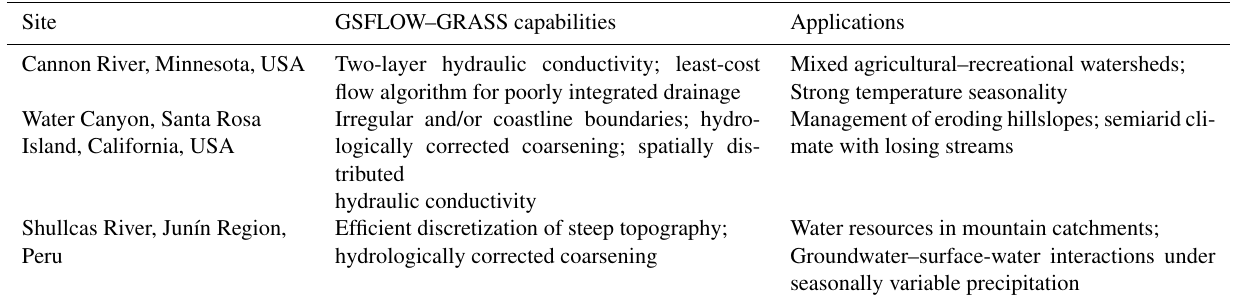
Table 3. Model implementations based on three sites to test GSFLOW–GRASS capabilities and demonstrate applications.